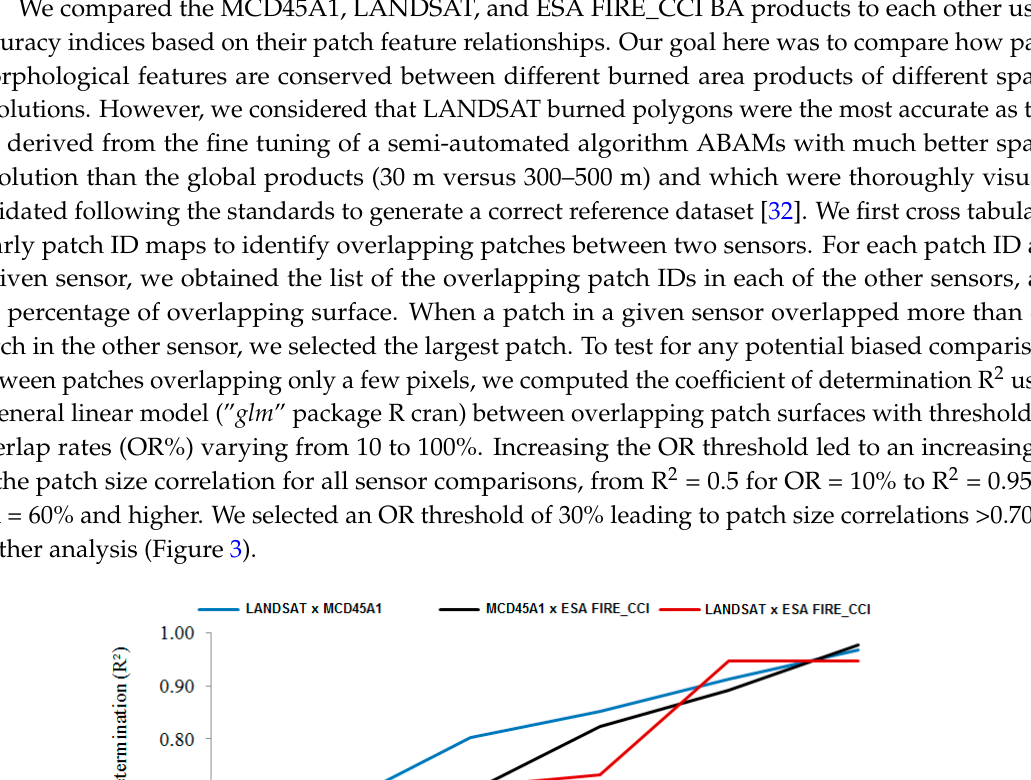
Table 2. Description of patch metrics for burn individual patches in each category.